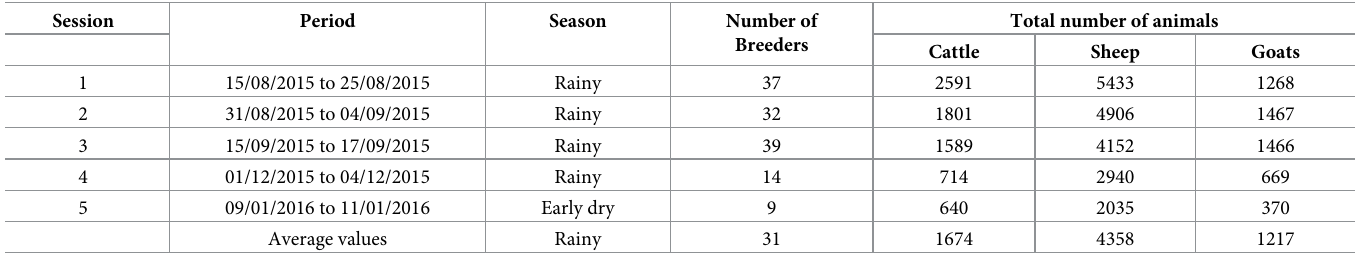
Table 1. Surveys conducted in nomadic breeders of the study